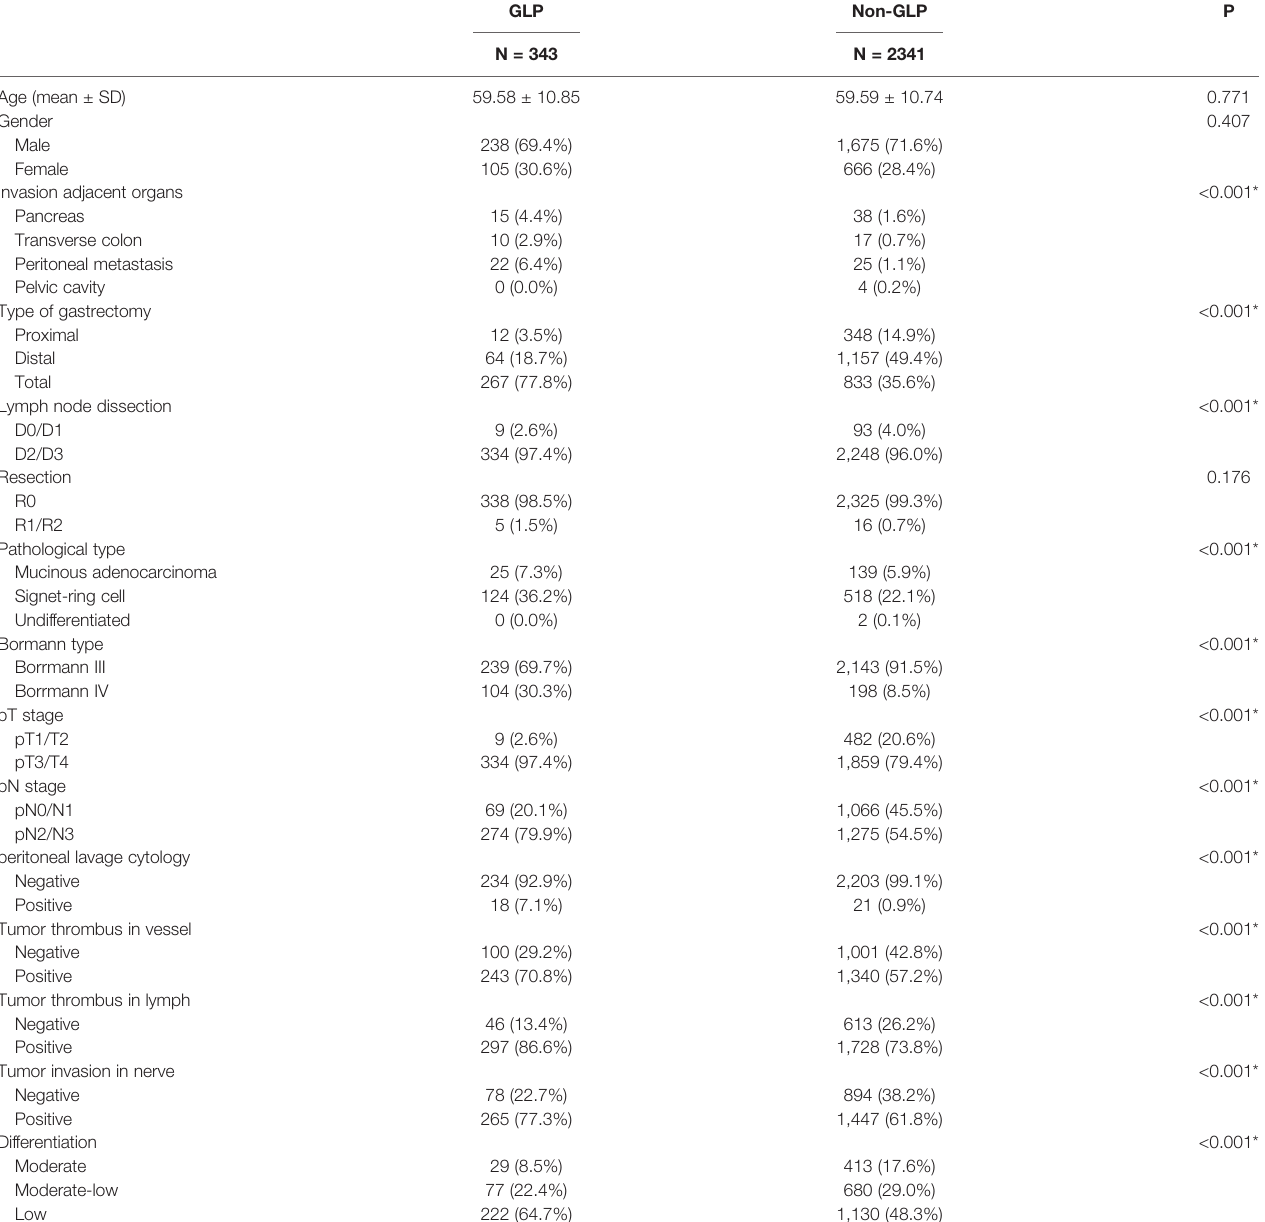
TABLE 2 | The difference of the clinicopathological features between GLP and